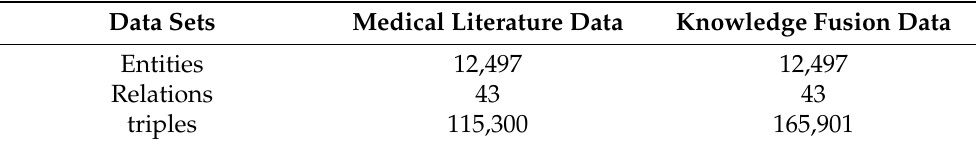
Table 1. Comparison of medical data sets before and after